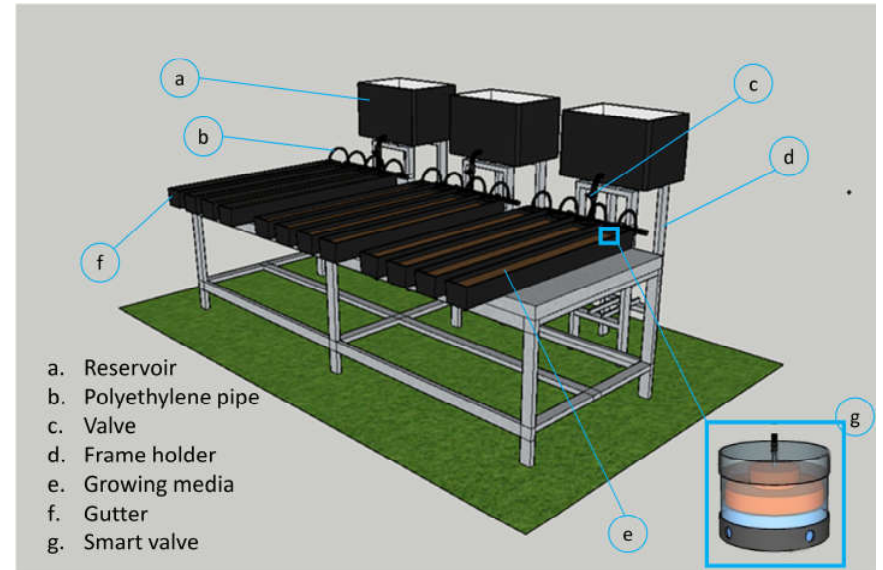
Figure 3. The construction of a hydroponic kit based on a self-fertigation